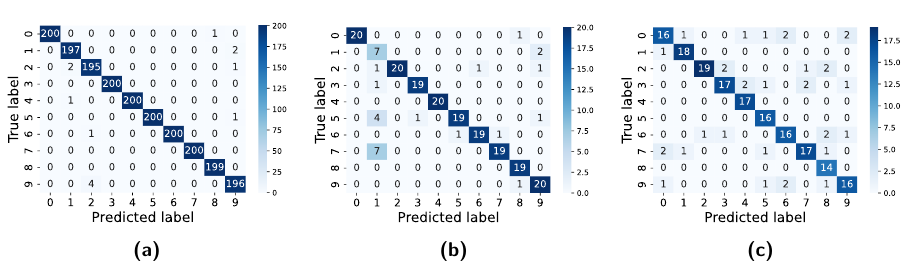
Figure 8: Confusion Matrix for timing test data on the MLP model (Custom CNN) in (a) single process scenario (b) 4-process scenario and, (c) 8-process